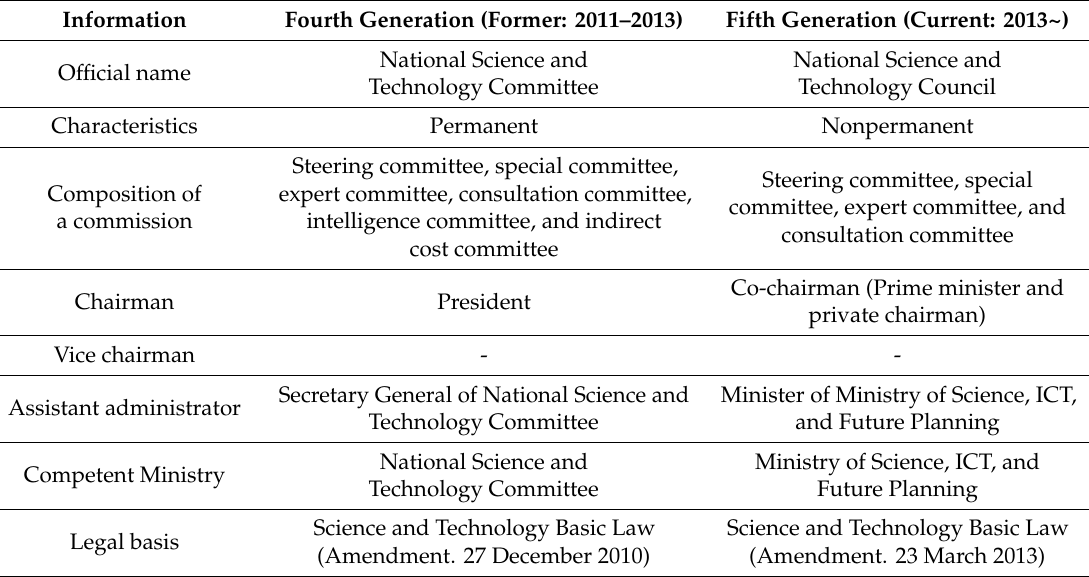
Table 1. History of National Science and Technology Council